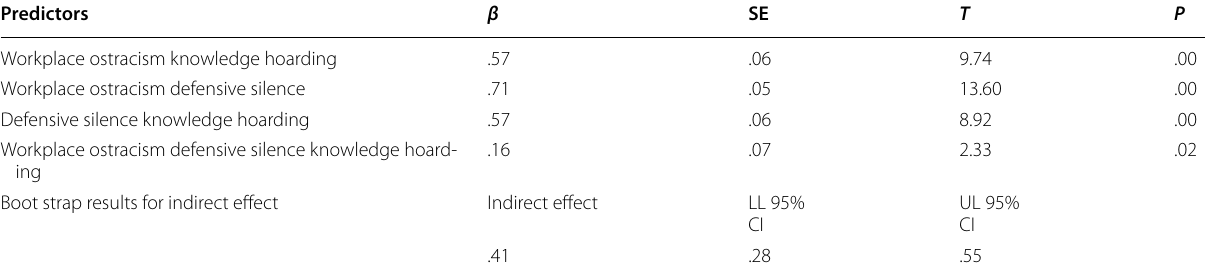
Table 6 Results of direct and indirect effects